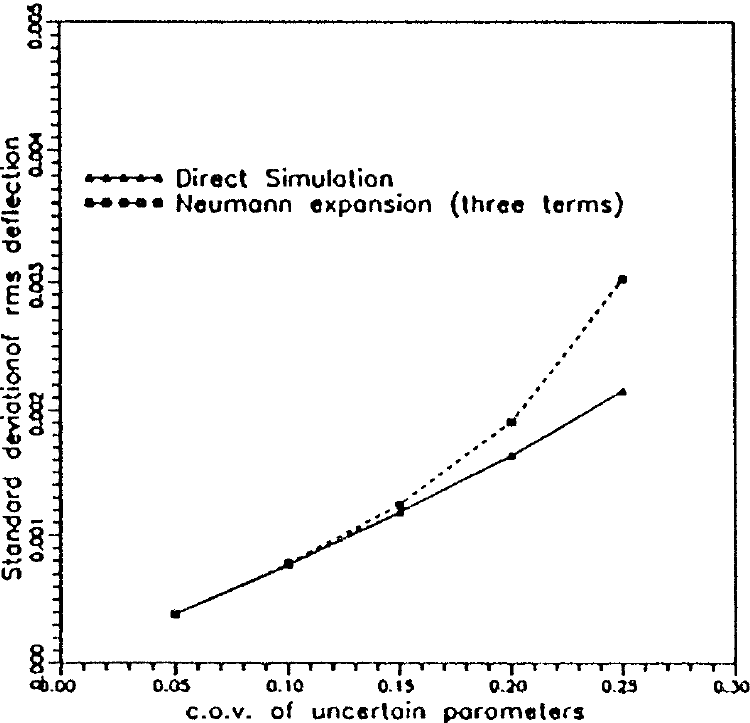
Fig. 8. Comparison of standard deviation of rms deflection at node 46 of the plate with varying c.o.v. of uncertain